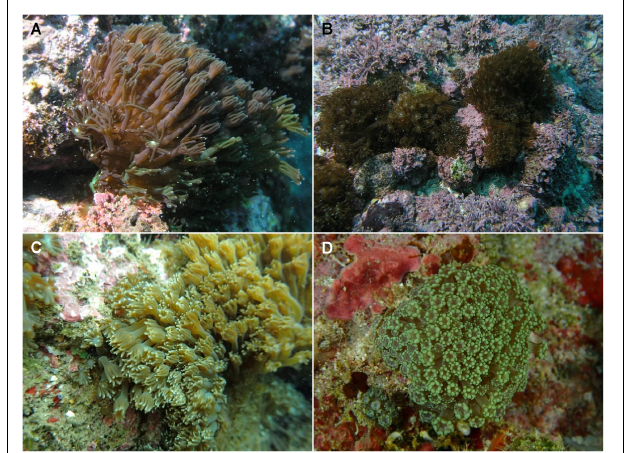
FIGURE 1 | Photos of Alveopora japonica . Bomok (A) and Geumneung (B) populations around Jeju Island, off the southern coast of Korea; Shimoda (C) on the central southern coast of Japan; Green Island (D) in Taiwan. Skeletal features of these samples are shown in Supplementary Figure S1